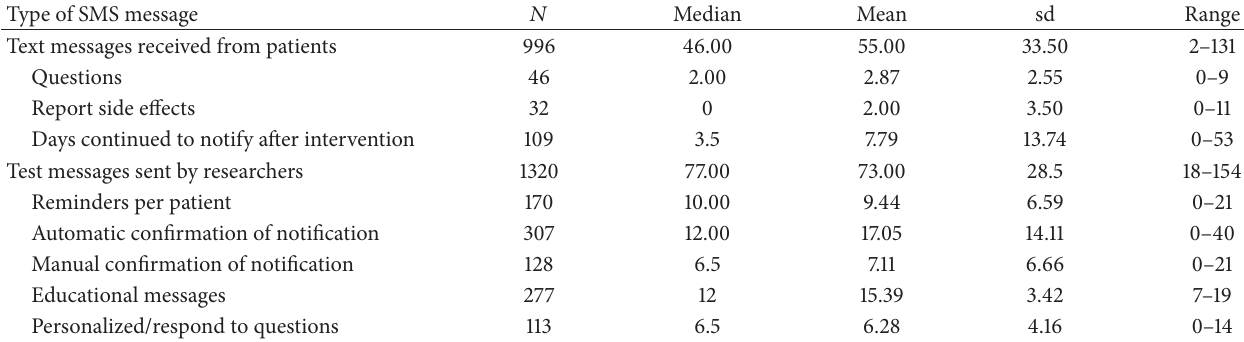
Table 2: Types of messages sent and received during intervention.